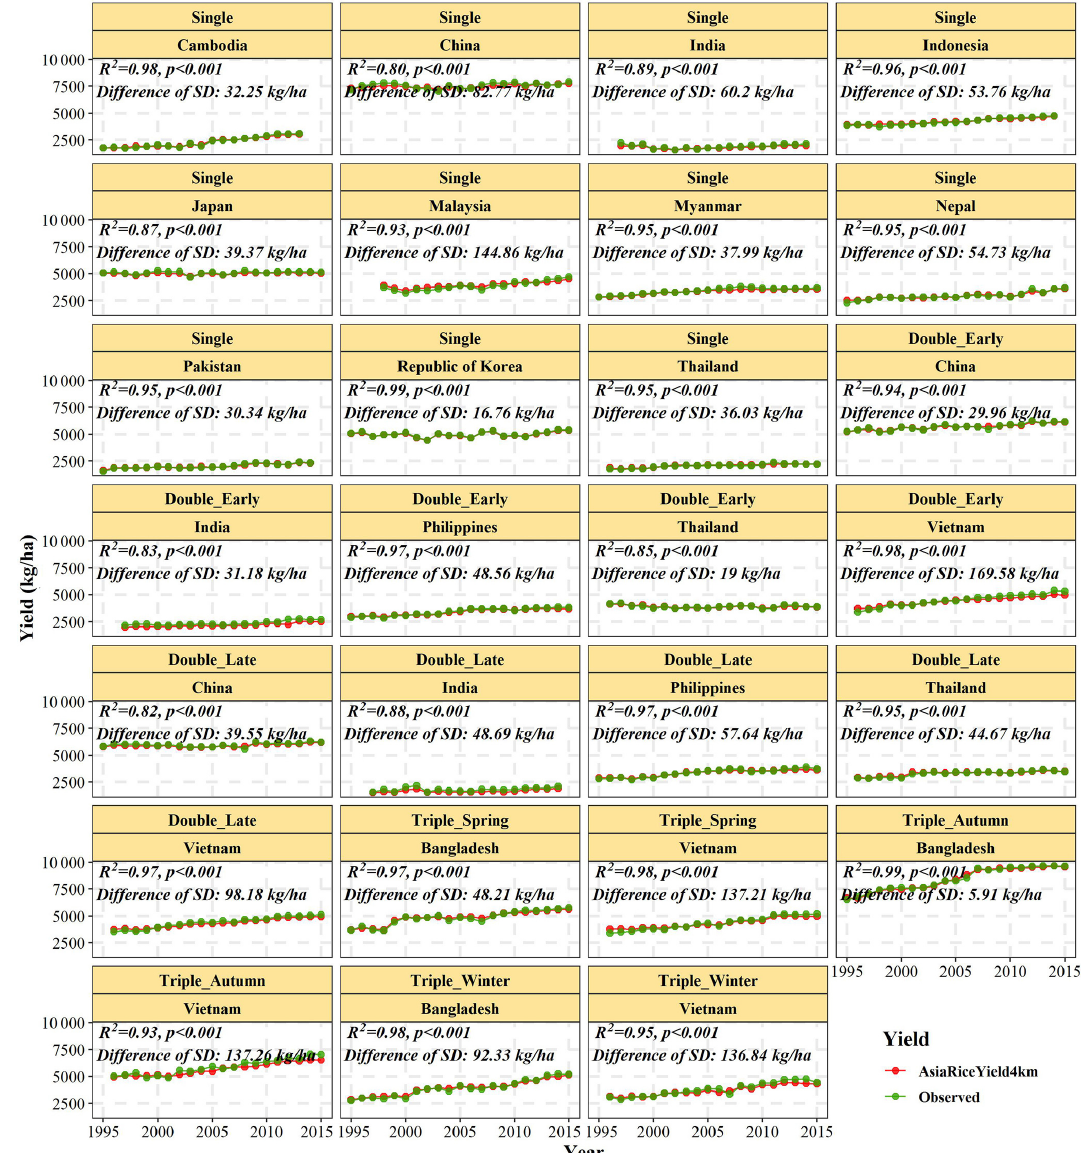
Figure 5. Interannual comparison of AsiaRiceYield4km with the observed yield from 1995 to